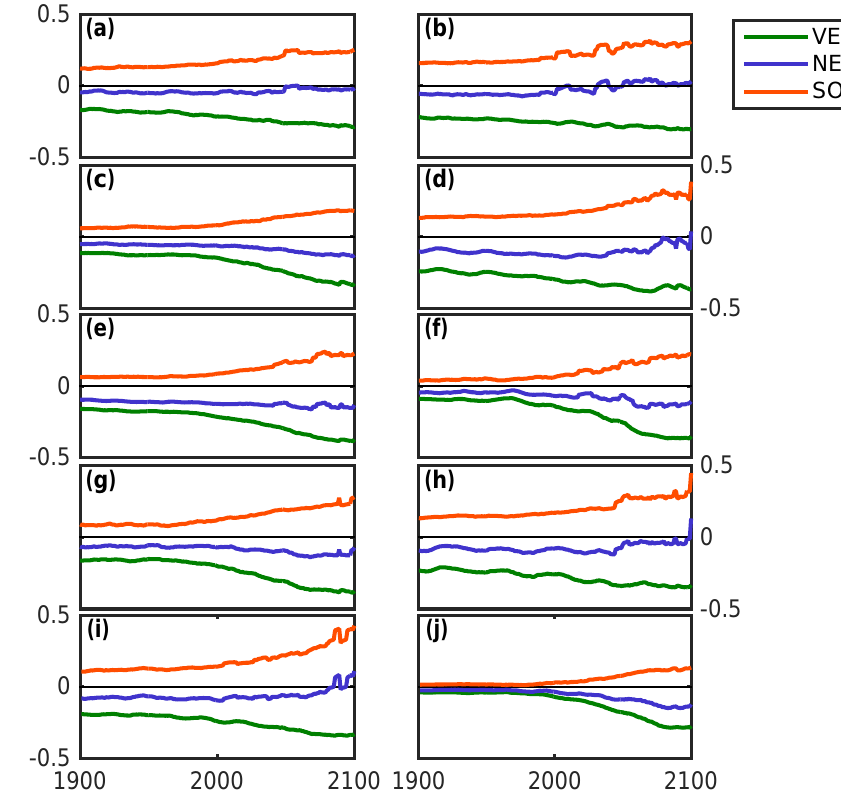
Figure A2. Total simulated carbon fluxes (10-year moving aver- age; inkg Cm − 2 yr − 1 ) for each zone for 1900–2100, including the RCP8.5 (FTPC8.5) forcing scenario for 2001–2100: vegetation NPP (VEG), net ecosystem exchange (NEE) and litter and soil res- piration